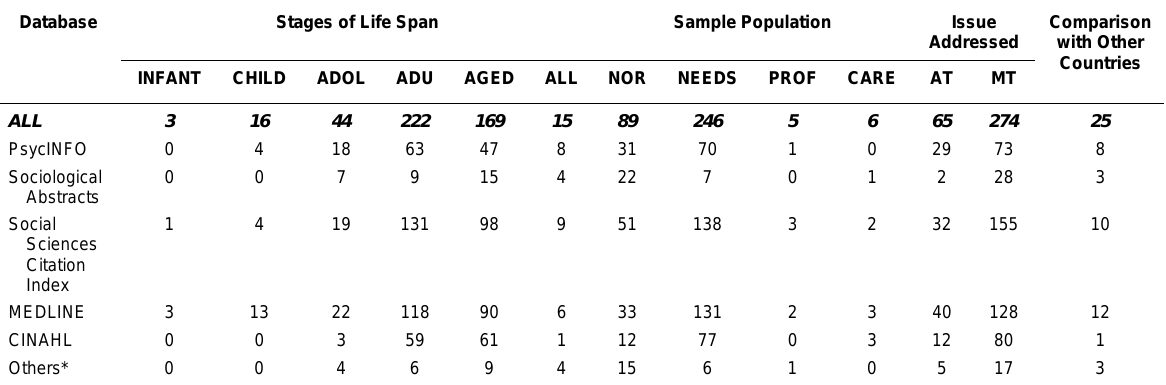
Classification of Studies about the QOL in Hong Kong in Four Dimensions (Stages of Life Span, Sample Population, Issue Addressed, and Comparison with Other